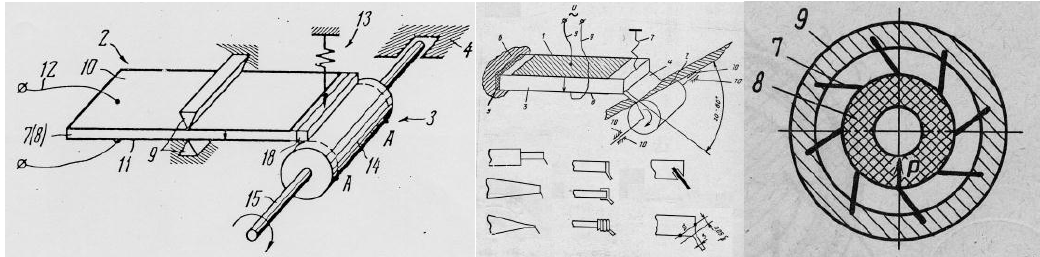
Figure 3. Piezoelectric motor introduced by V. Lavrinenko in 1965 [3].